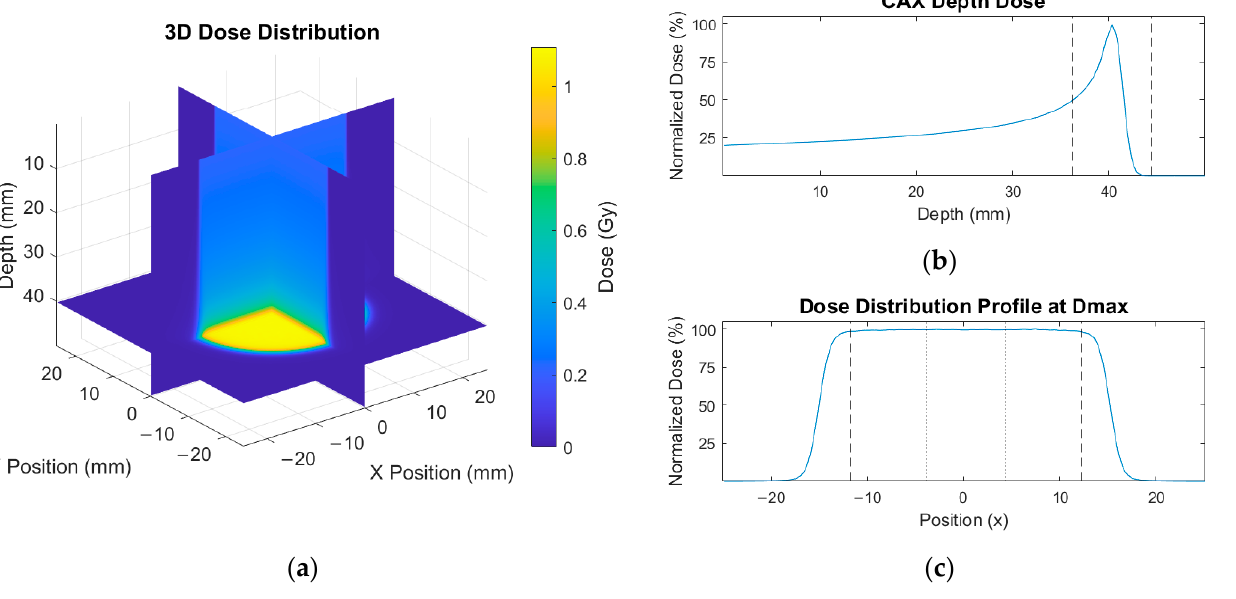
Figure 4. Dose from a Monte Carlo-simulated 70 keV proton beam. The 3D dose distribution ( a ), central axis PDD ( b ), and dose profile at the depth of maximum dose ( c ) are shown. The profile and PDD have been normalized to the maximum dose. The CAX region (dotted lines) and beam region (dashed lines) on the profile and the Bragg Peak region (dashed lines) for the PDD are indicated.